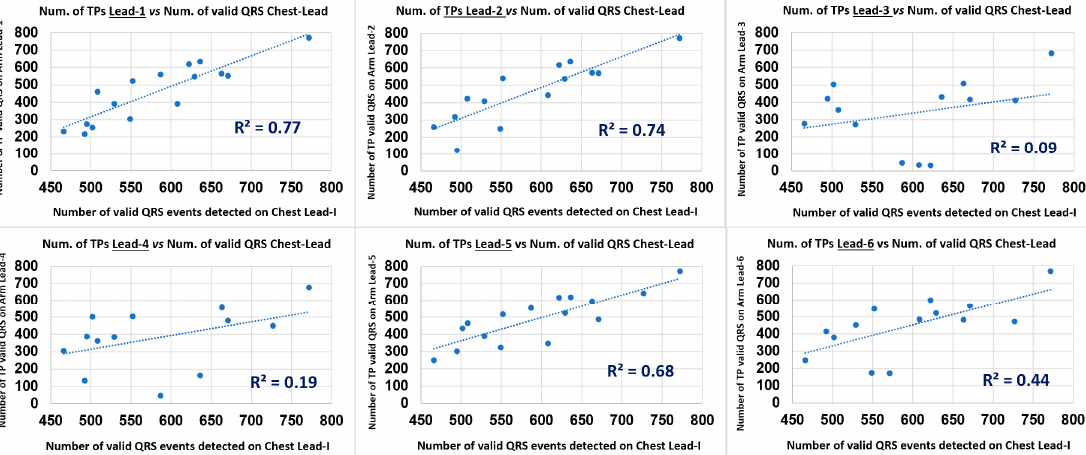
Figure 6. Bar charts for results in Table 5: arm-leads (1–6) values of NTPqrs vs. number of valid QRS in the Chest Lead I (NVChestQRS): ( a ) Pearson correlation (p), and ( b ) trendline coefficient of determination (R 2 ).